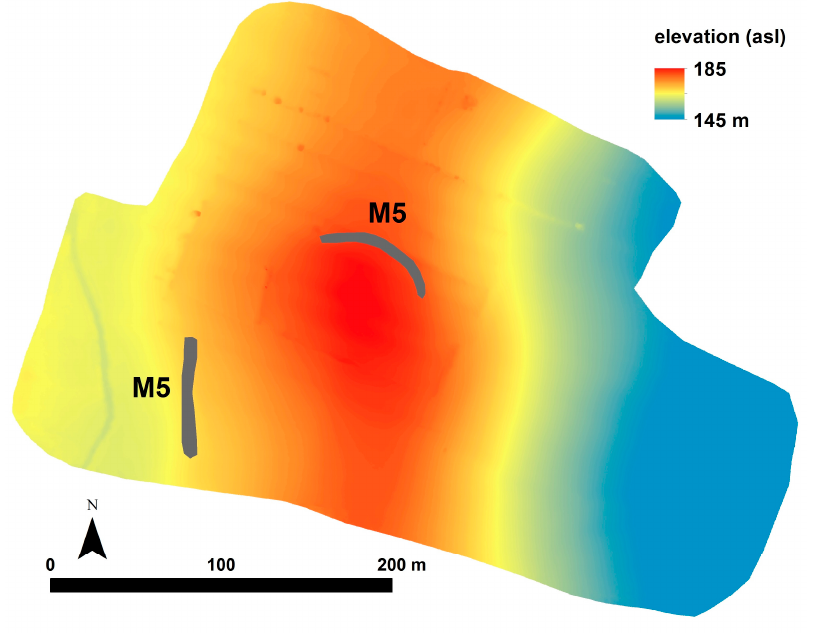
Figure 9. A Digital Terrain Model is processed from RPAS imagery. The details of the model provide further proof for the location and extent of settlement enclosures.